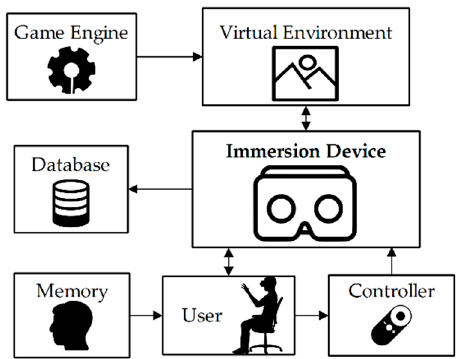
Figure 1. Formulation of the memory rehabilitation problem using an immersive virtual reality application.